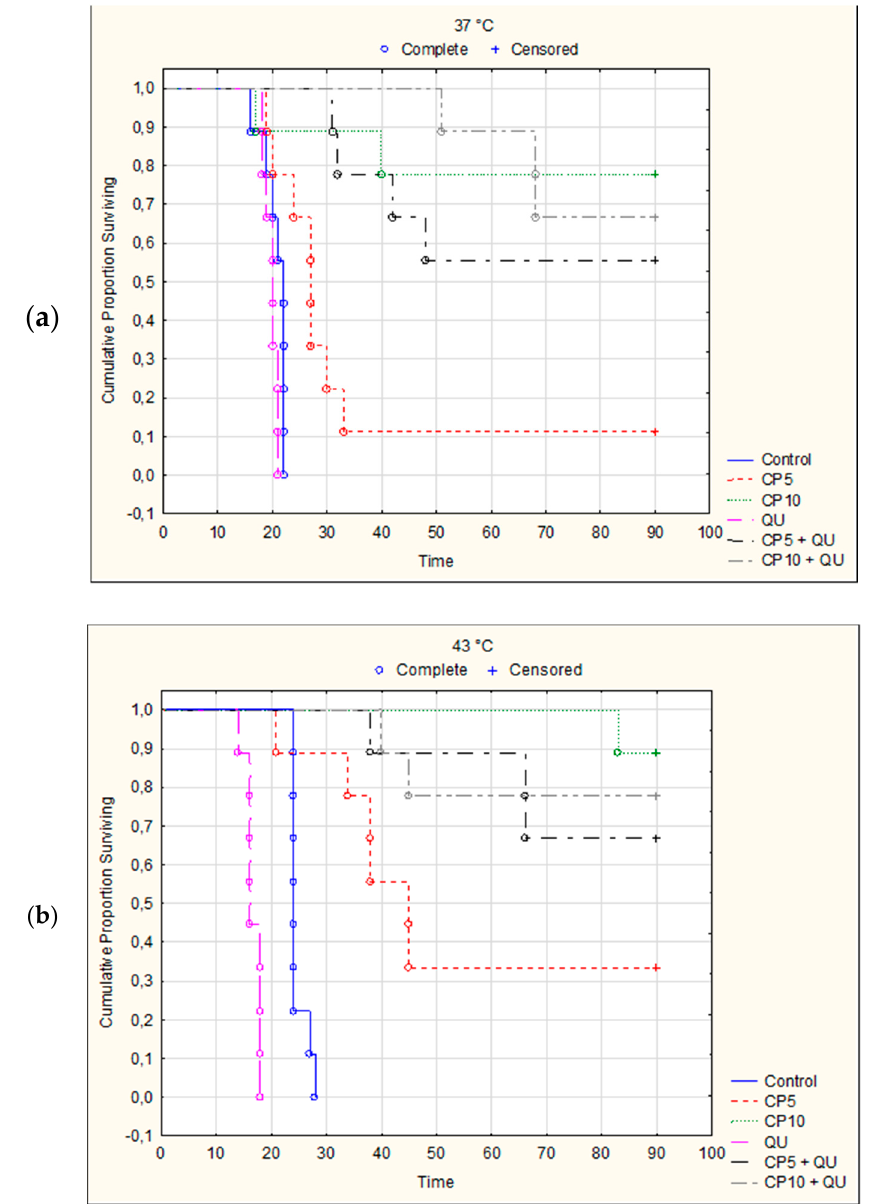
Figure 4. Kaplan–Meier survival curves of Swiss albino mice bearing Ehrlich ascites tumor after therapeutic treatment with quercetin and cisplatin under physiological condition ( A ) and hyperthermic condition ( B ). Mice were treated with CP (5 or 10 mg kg − 1 , i.p. ) 5th day after i.p. inoculation of EAT cells (2 × 10 6 /mouse) under physiological and hyperthermic conditions and with QU ( i.p. 50 mg kg − 1 ) at day 6 and 12 after i.p. inoculation of EAT cells. The number of mice in each experimental group was 9. Statistical significance in animal survival under physiological or hyperthermic conditions and between controls under both temperature is shown in Table 4.